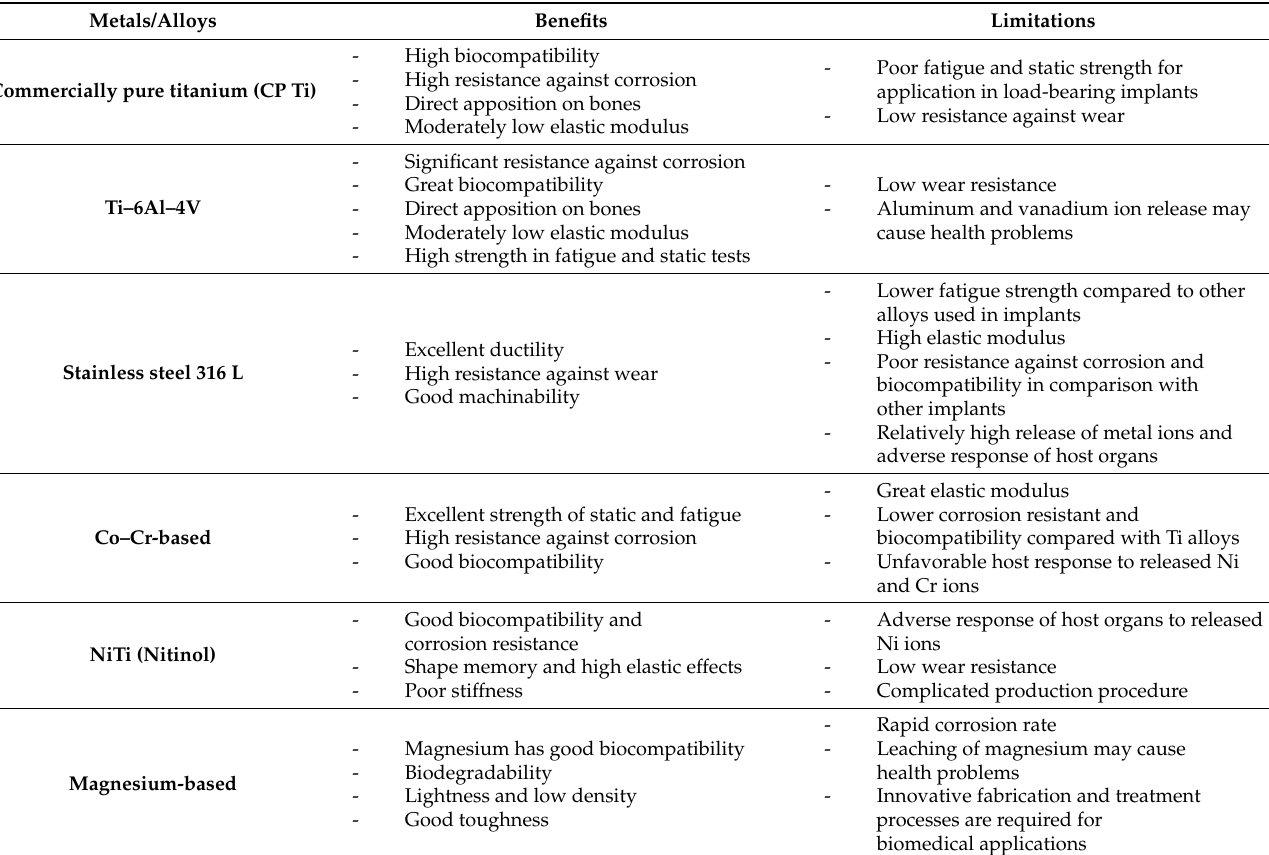
Table 1. An overview of metals used as biomedical